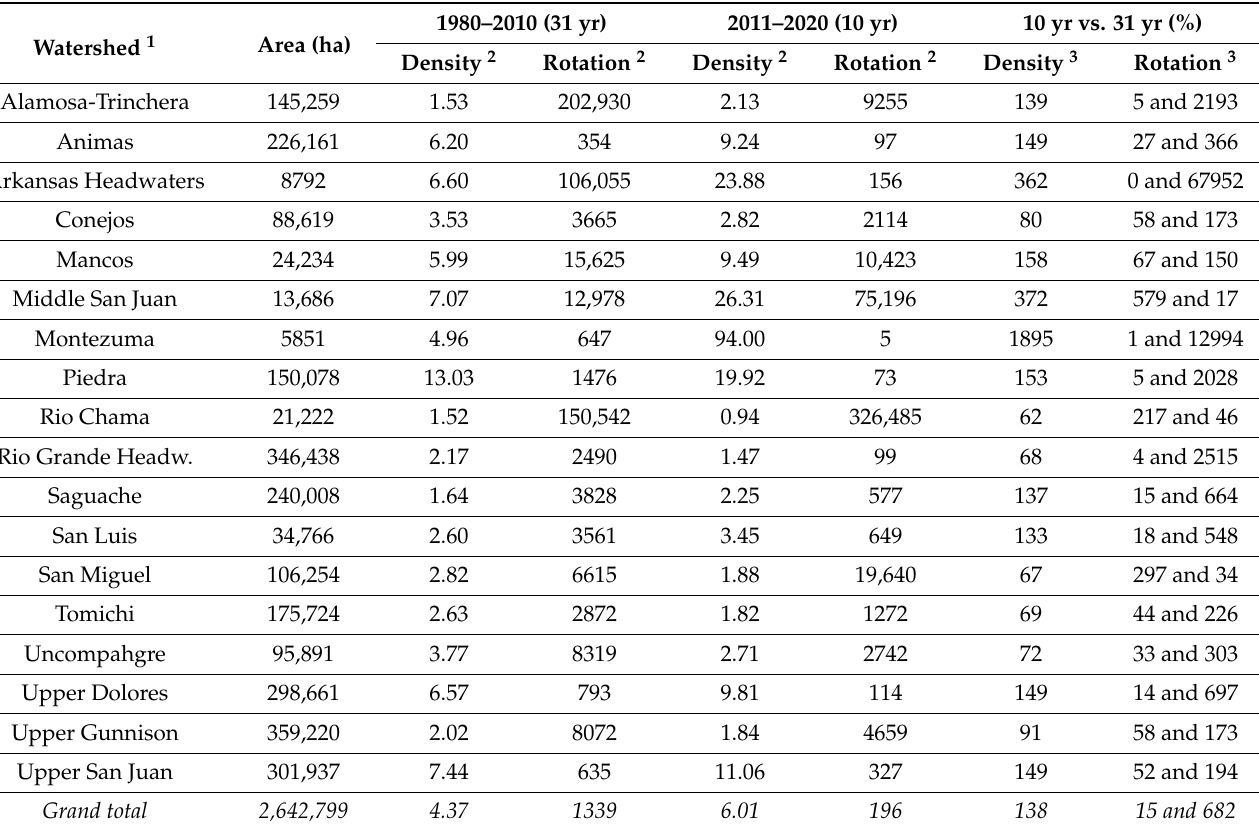
Table 5. Estimated fire densities and fire rotations for 1980–2010 (31 years) compared to 2011–2020 (10 years) by watershed and